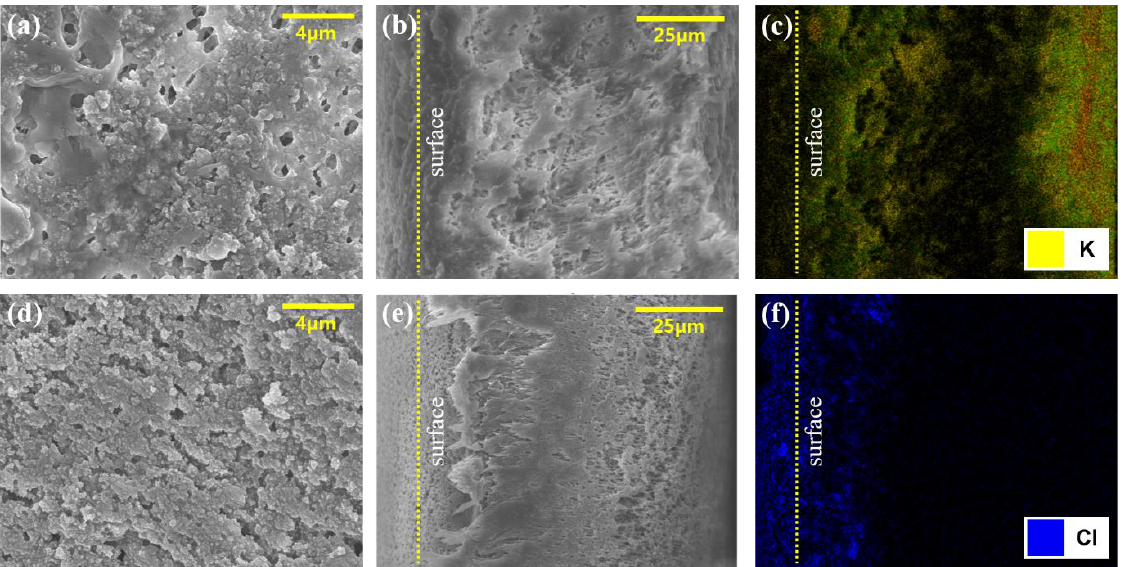
Figure 9. An SEM and SEM-EDS image of LiCl and HCOOK after no cleaning concentration. ( a , d ) are surface SEM images of HCOOK and LiCl. ( b , e ) are cross-sectional SEM images of HCOOK and LiCl. ( c , f ) are cross-sectional SEM-EDS images of HCOOK and LiCl.